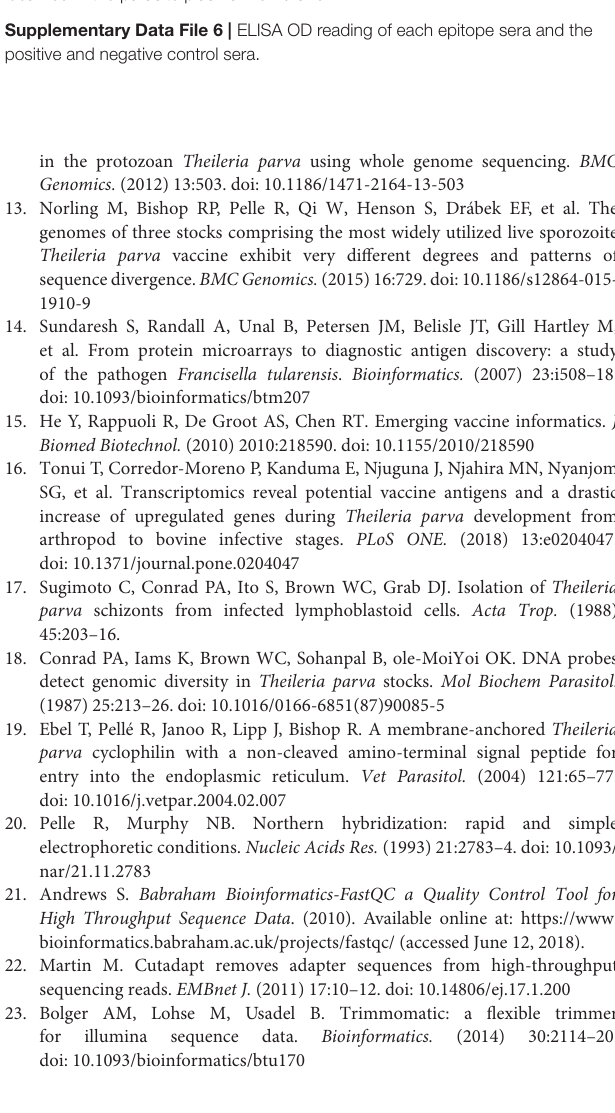
Supplementary Data File 2 | List of the stage-specific genes. Supplementary Data File 3 | List of genes associated to the GO term and KEGG term. Supplementary Data File 4 | Genes with similar expression pattern to the known antigens. Supplementary Data File 5 | Candidate vaccine proteins predicted to be localized in the parasite plasma